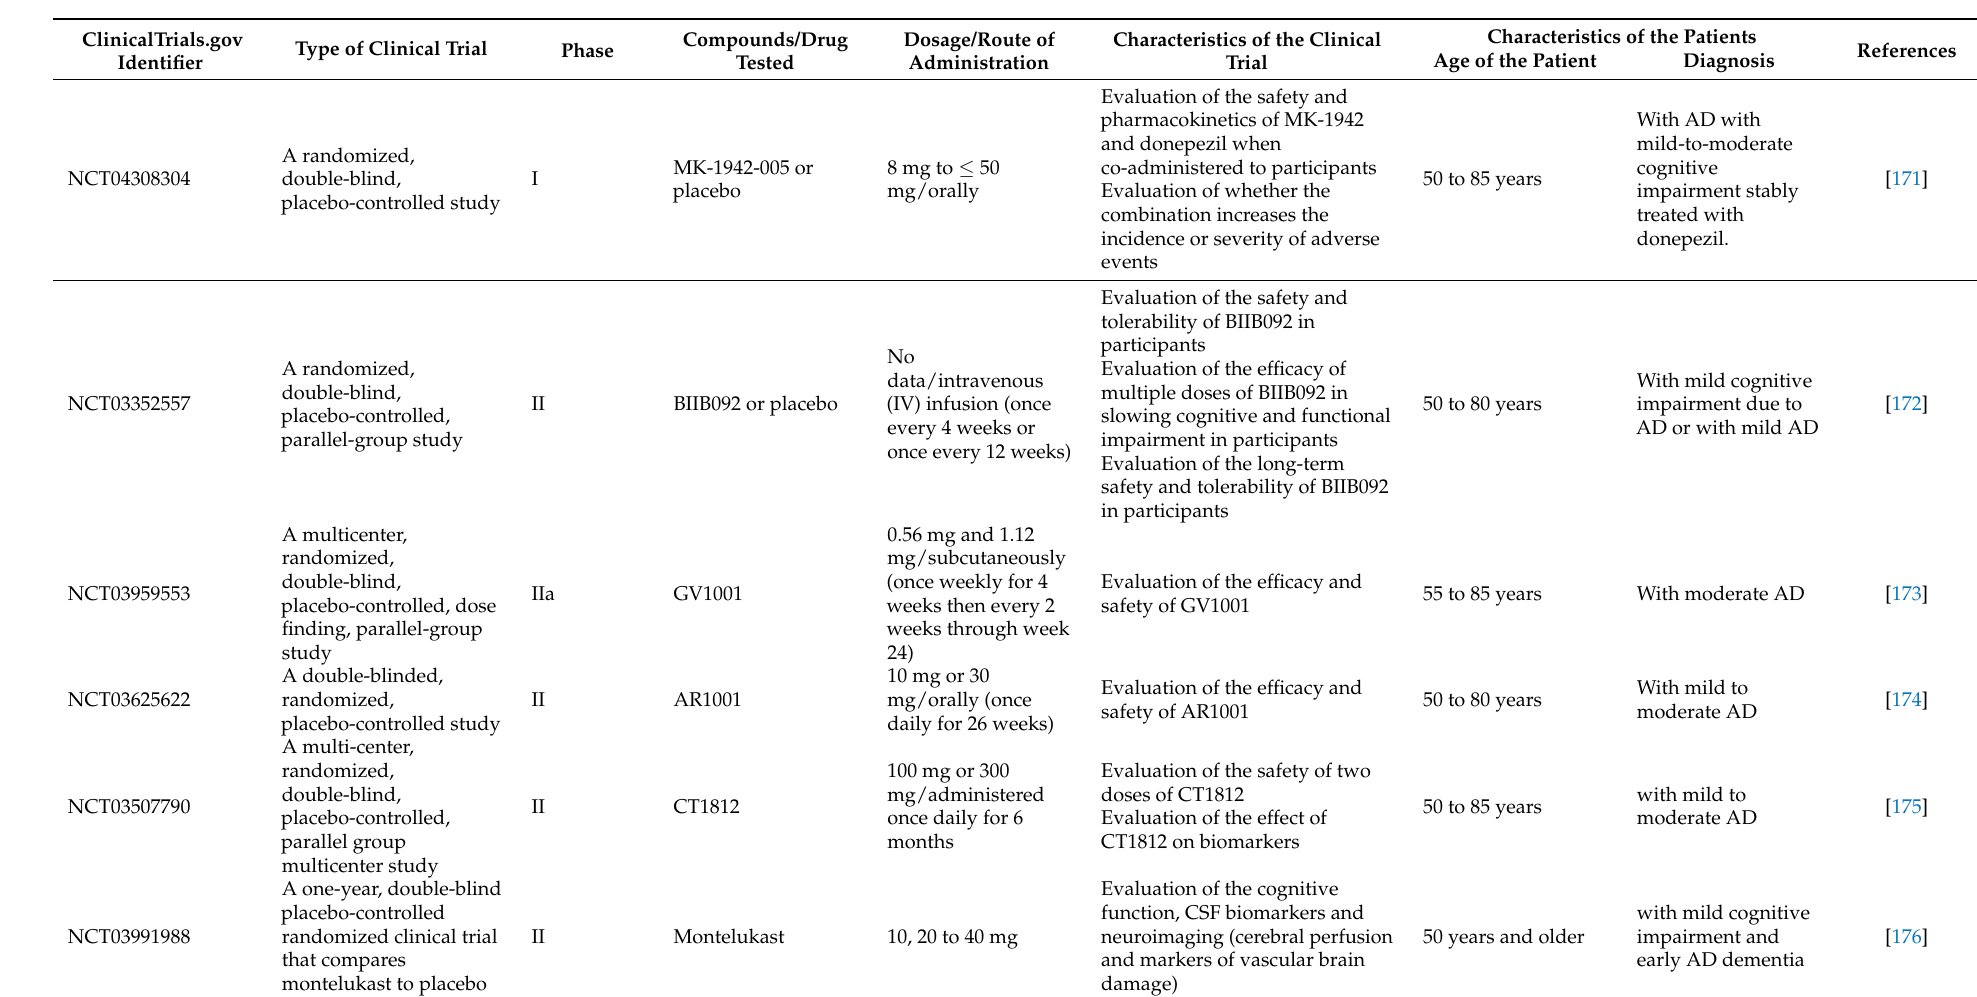
Table 4. Currently conducted, selected clinical